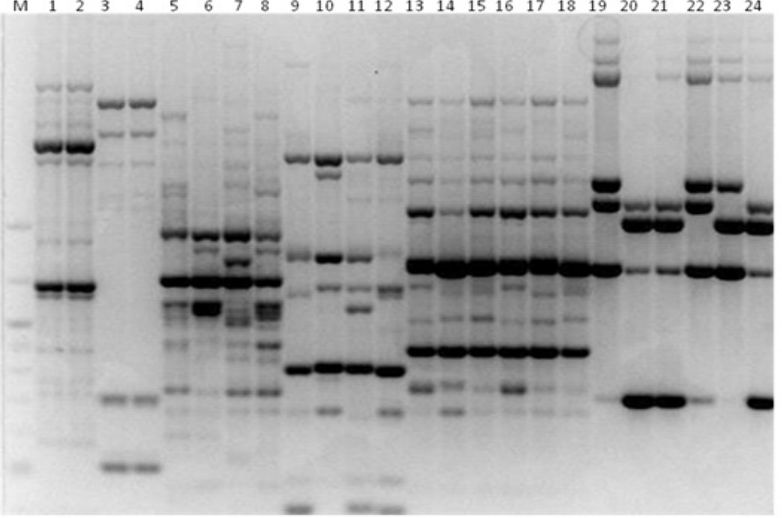
Figure 2. RAPD profiles generated with primers R5 (lanes1-2, 5–8 and 13–18) and RF2 (lanes 3–4, 9–